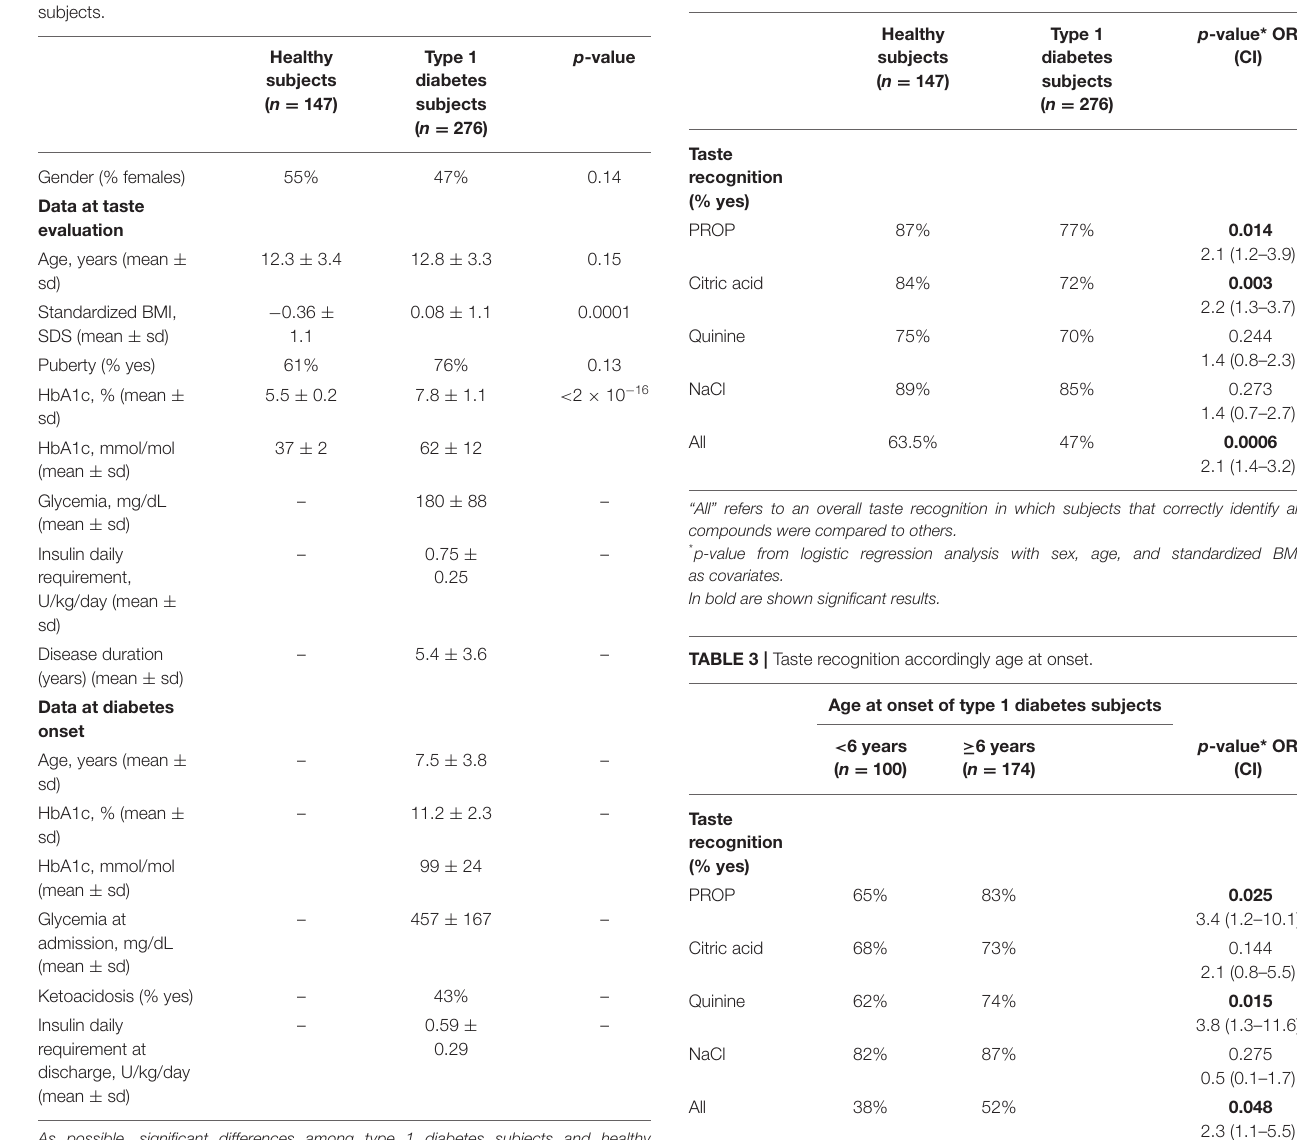
TABLE 2 | Taste recognition in healthy subjects and type 1 diabetes subjects.